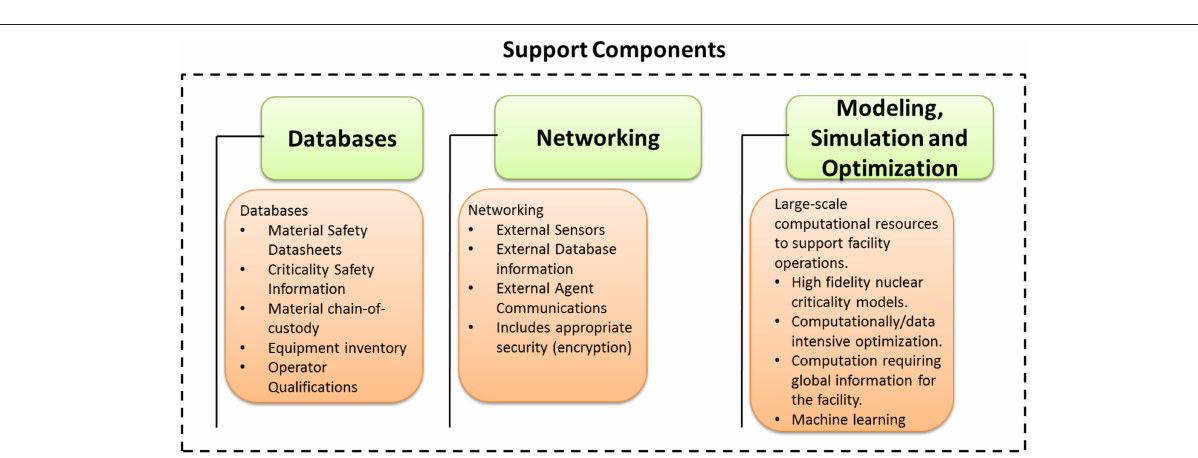
FIGURE 6 | The supporting components for the software framework. The components are used to supply and document relevant information for the software components that the user interacts